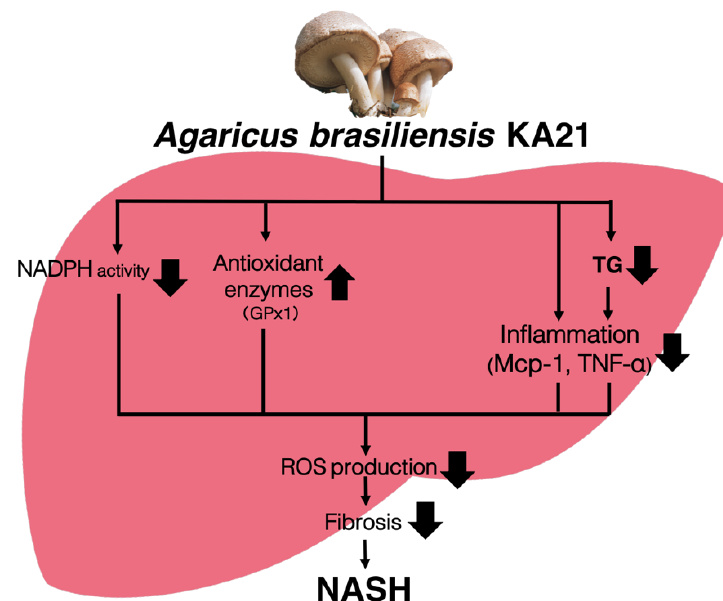
Figure 5. Expected pathway for non-alcoholic steatohepatitis (NASH) prevention by Agaricus brasiliensis KA21. NASH; reactive oxygen species (ROS); free fatty acids (FFA); triglycerides (TG); 2-thiobarbituric acid reactive substances (TBARS); nicotinamide adenine dinucleotide phosphate (NADPH); glutathione peroxidase (Gpx1); monocyte chemotactic protein-1 (MCP-1); tumor necrosis factor alpha (Tnfa).